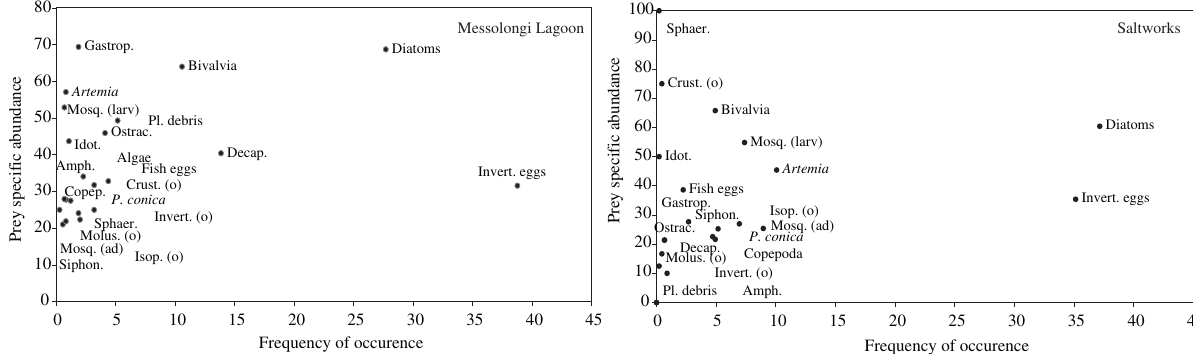
Fig . 2. – relationship among prey specific abundance (Pi) and Frequency of occurrence (% Fi) of food categories of Aphanius fasciatus diet. Plots based on the modified Costello graphical method (amundsen et al ., 1996). Food categories described are the most important in diet. (Gastrop.= Gastropoda, Mosq. (larv) = Mosquito larvae, Pl. debris = Plant debris, ostrac. = ostracoda, Idot. = Idoteidae, decap. = decapoda, amph.=amphipoda, Invert. eggs= Invertebrate eggs, Crust. (o)= Crustacea (other), Copep.= Copepoda, P. conica = Pirinella conica , Invert. (o) = Invertebrates (other), sphaer. = sphaeromatidae, Molusc (o) = Molusca (other), Mosq. (ad)= Mosquito (adults), Isop. (o)= Isopoda (other), siphon. = siphonophora.